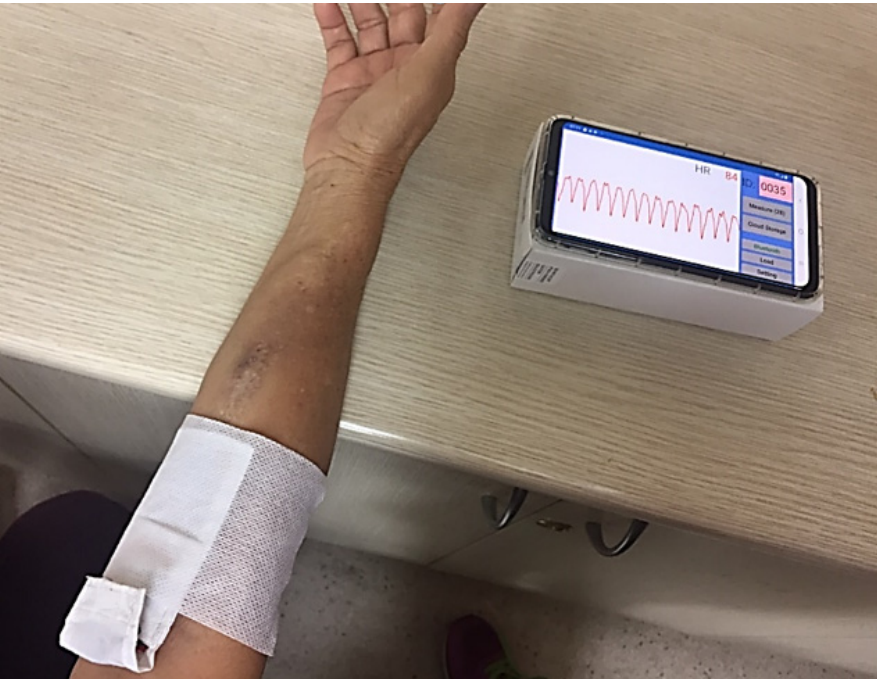
Figure 3. The hemodialysis patient during testing using a pulse radar sensor. Note that the App displays the signal waveform on a mobile phone. The detailed strategy of immobilizing as developed by the VWM monitoring system on patients, shown in Appendix